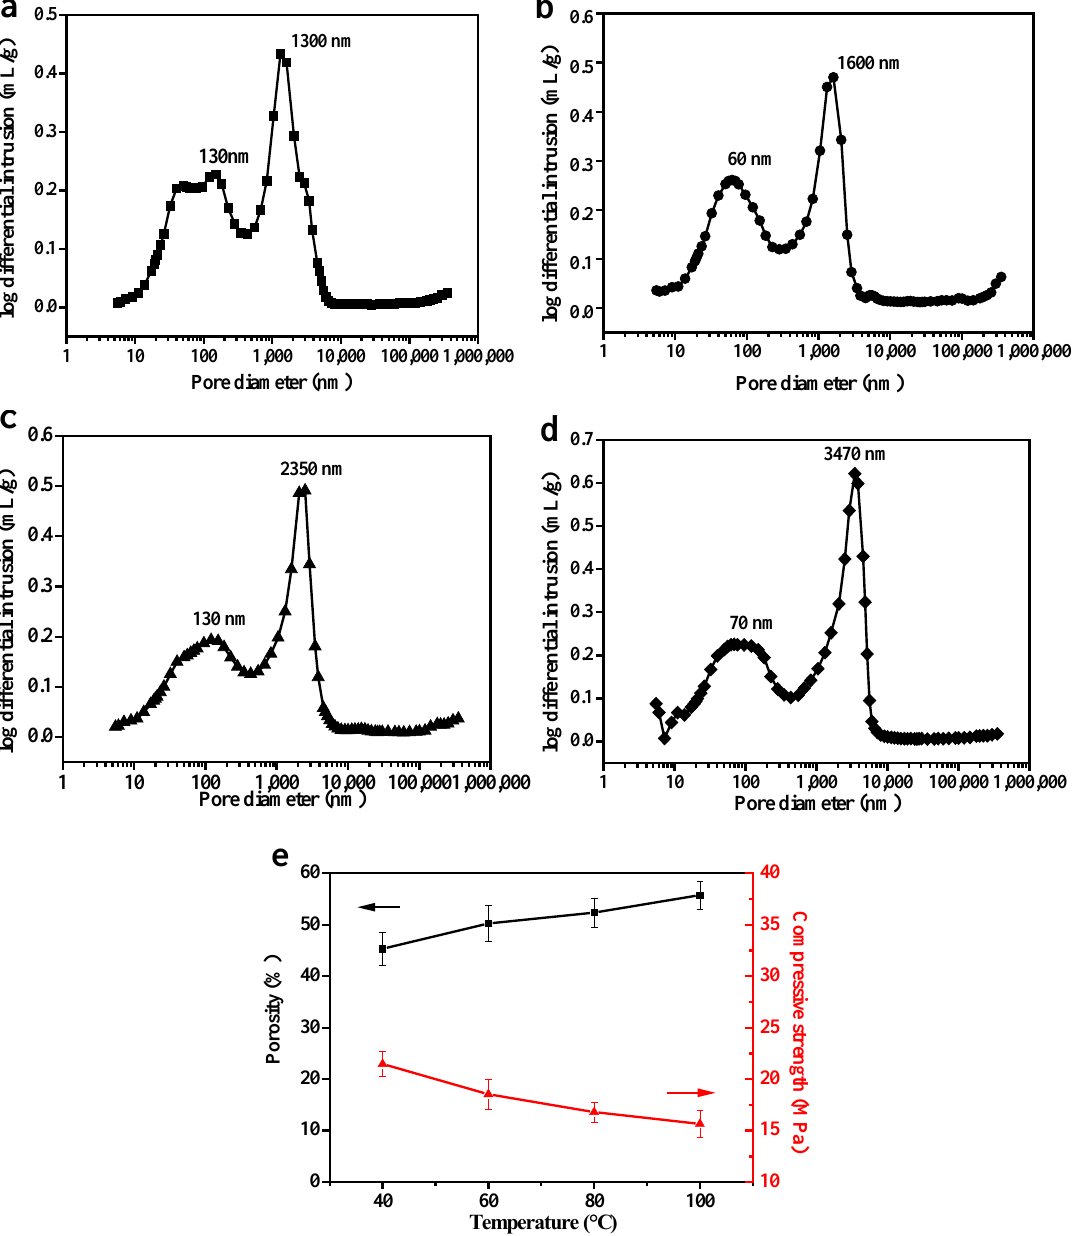
Figure 8. Pore size distribution of PSCMs based on the hot–dry casting process at ( a ) 40 ° C, ( b ) 60 ° C, ( c ) 80 ° C, and ( d ) 100 ° C. ( e ) Porosity and compressive strength at the above hot–dry tempera- ( c ) 80 ◦ C, and ( d ) 100 ◦ C. ( e ) Porosity and compressive strength at the above hot–dry tures.